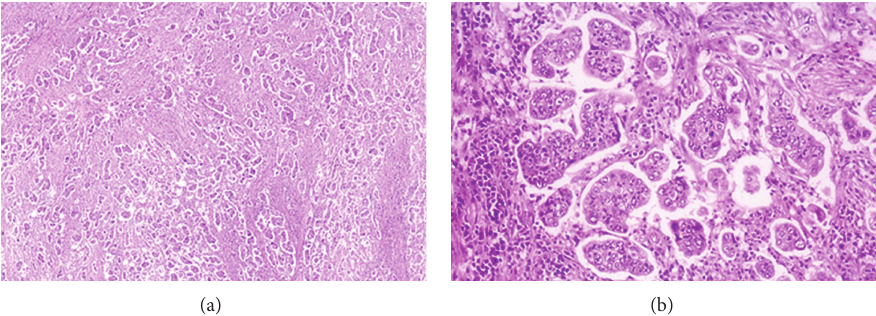
Figure 3: Histological examination of the specimen revealed that the tumor consisted of an invasive micropapillary component. Carcinoma cell clusters were floating in the clear spaces. (a) Hematoxylin-eosin stain, original magnification, × 40. (b) Hematoxylin-eosin stain, × 200.